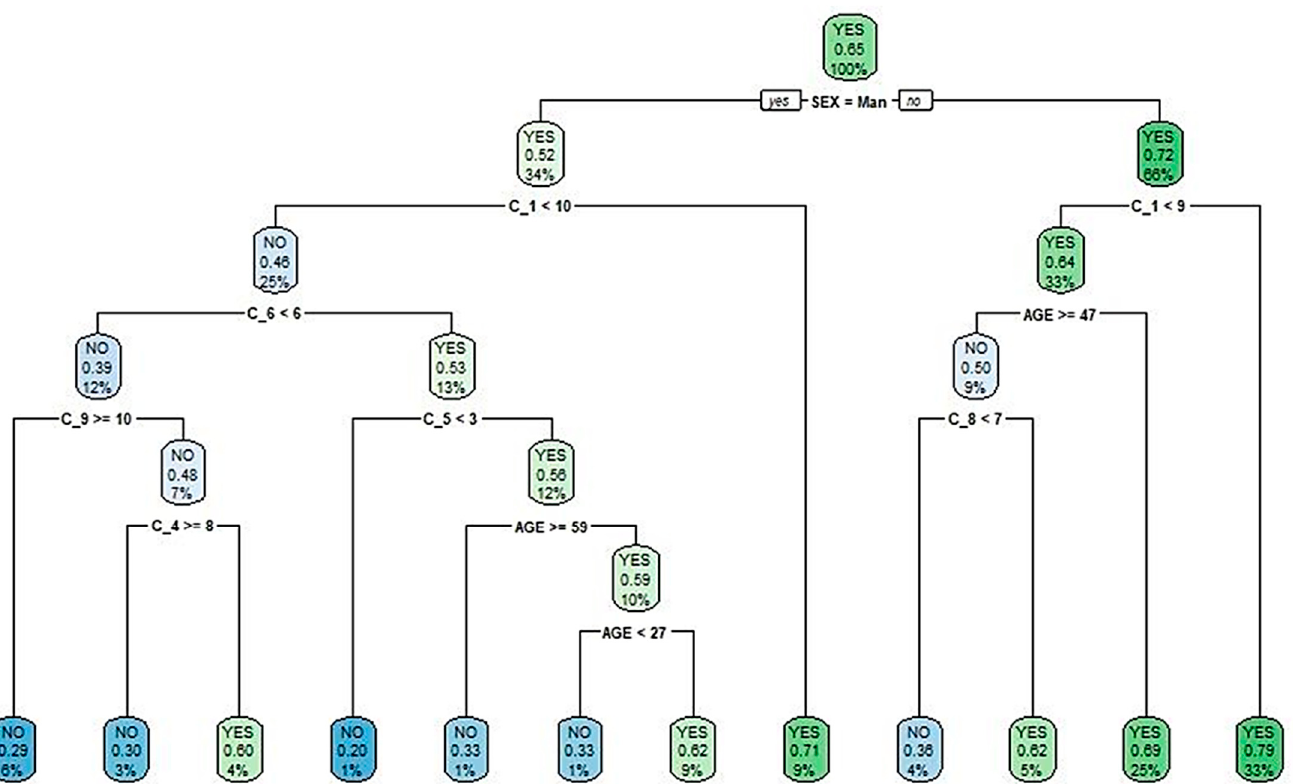
Figure 2. Classification and regression tree (CART) for psychological distress among non-health workers during the pandemic, based on beliefs about the outbreak.